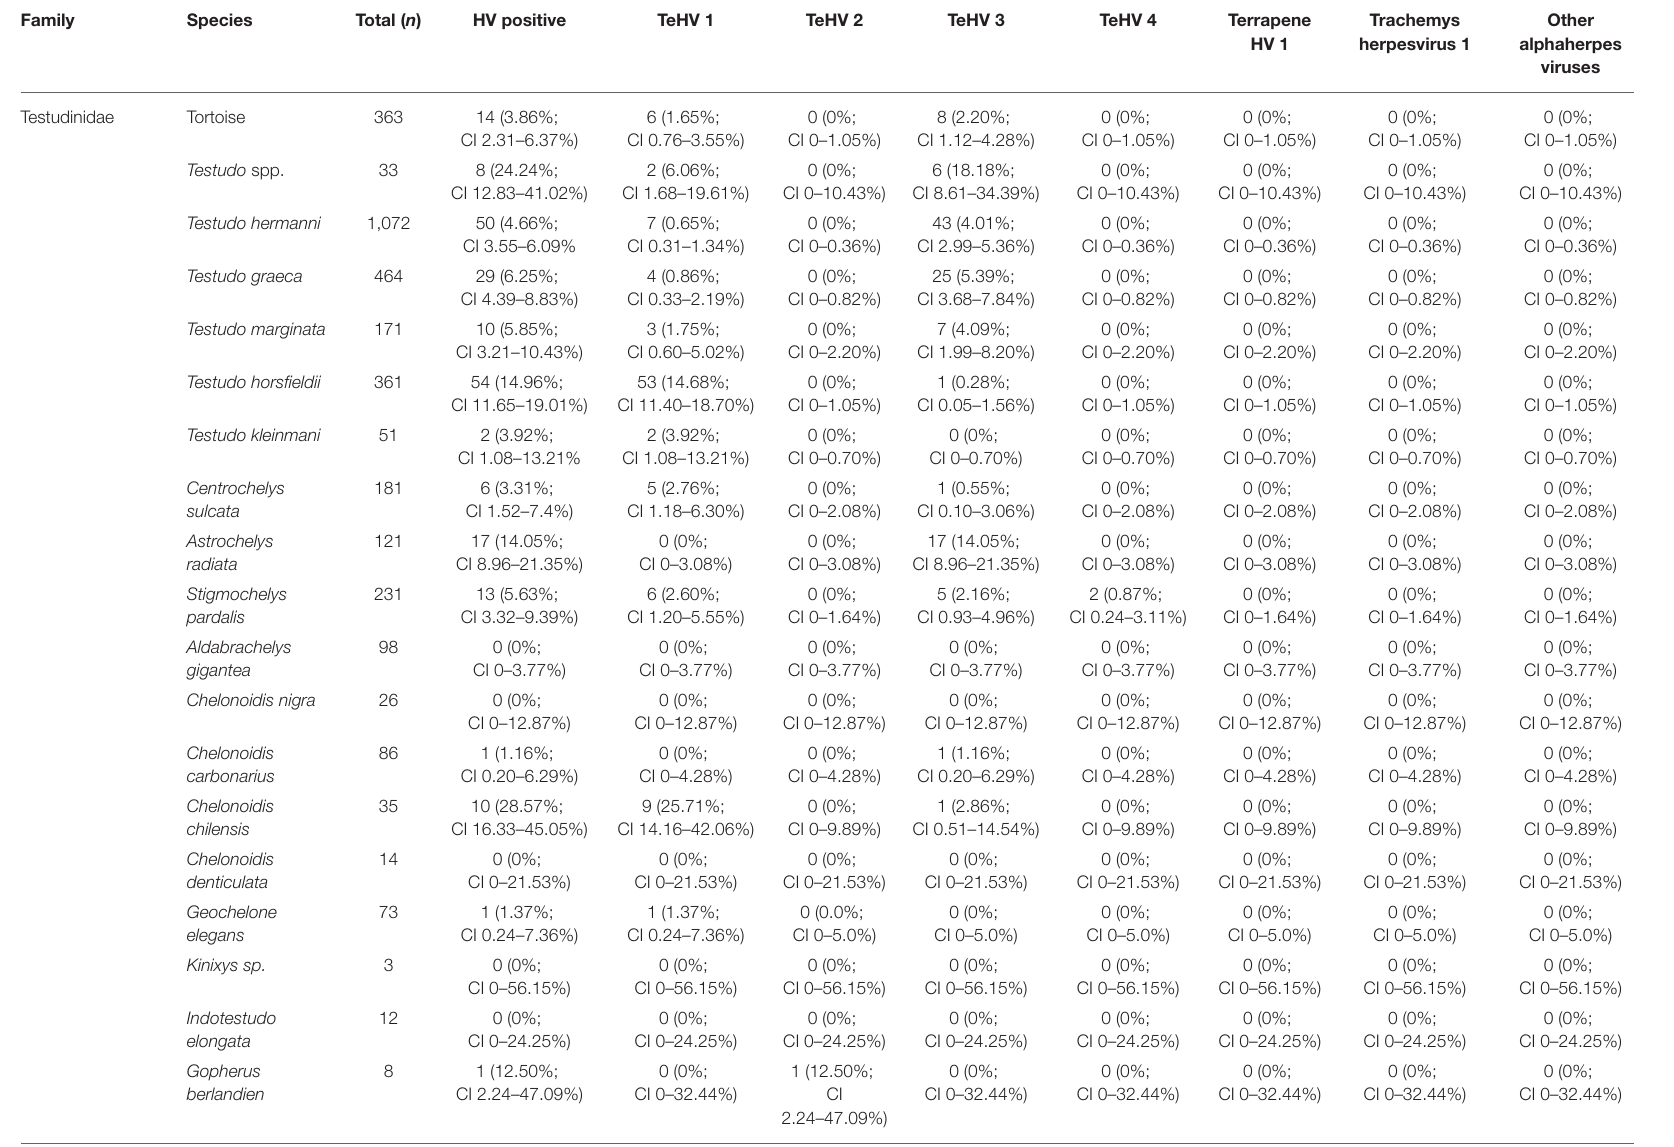
TABLE 1 | Chelonian species tested and herpesvirus positivity rate depending on species and virus